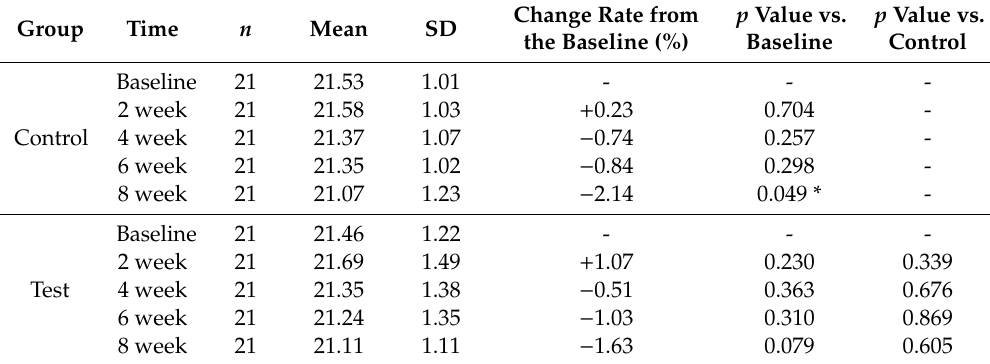
Table 8. Skin yellowness (b* value) of the control and test